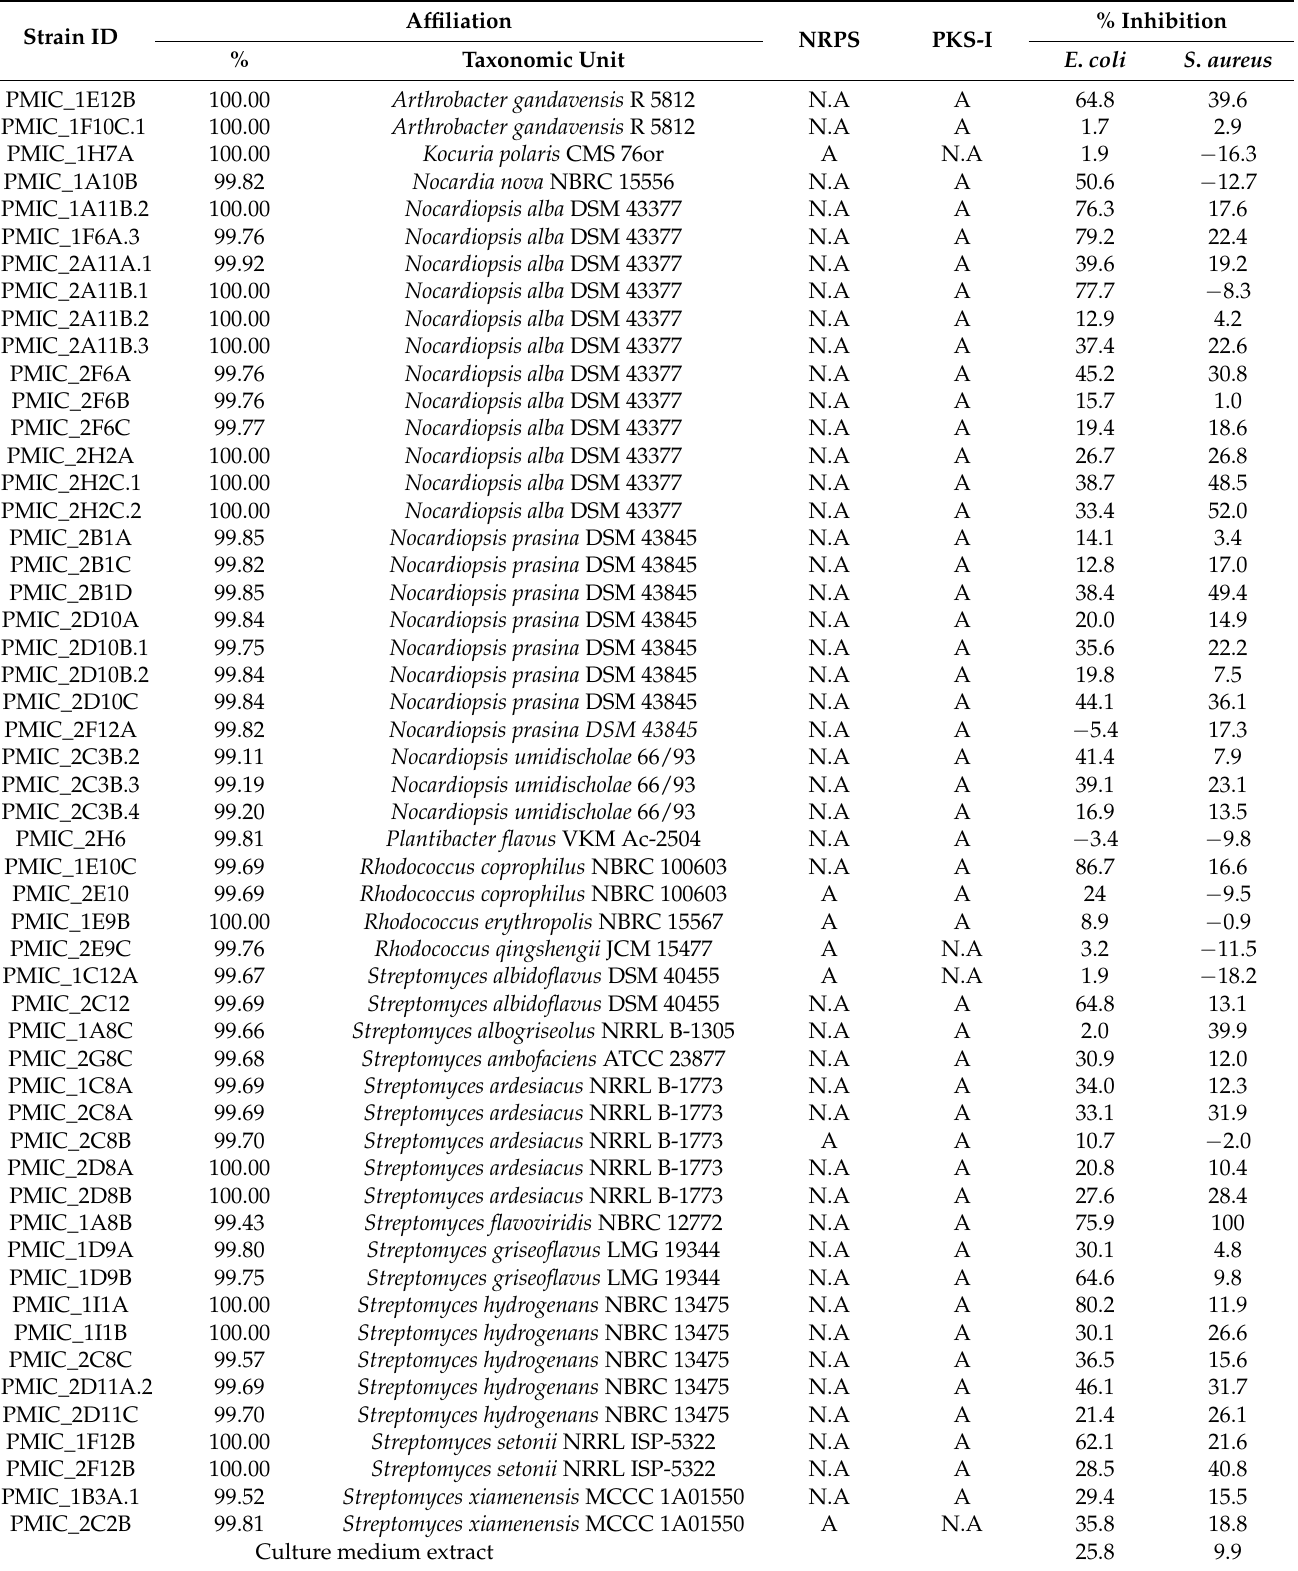
Table 1. Presence of secondary metabolism genes in Actinobacterial strains and mean inhibition of the extracts produced from the first